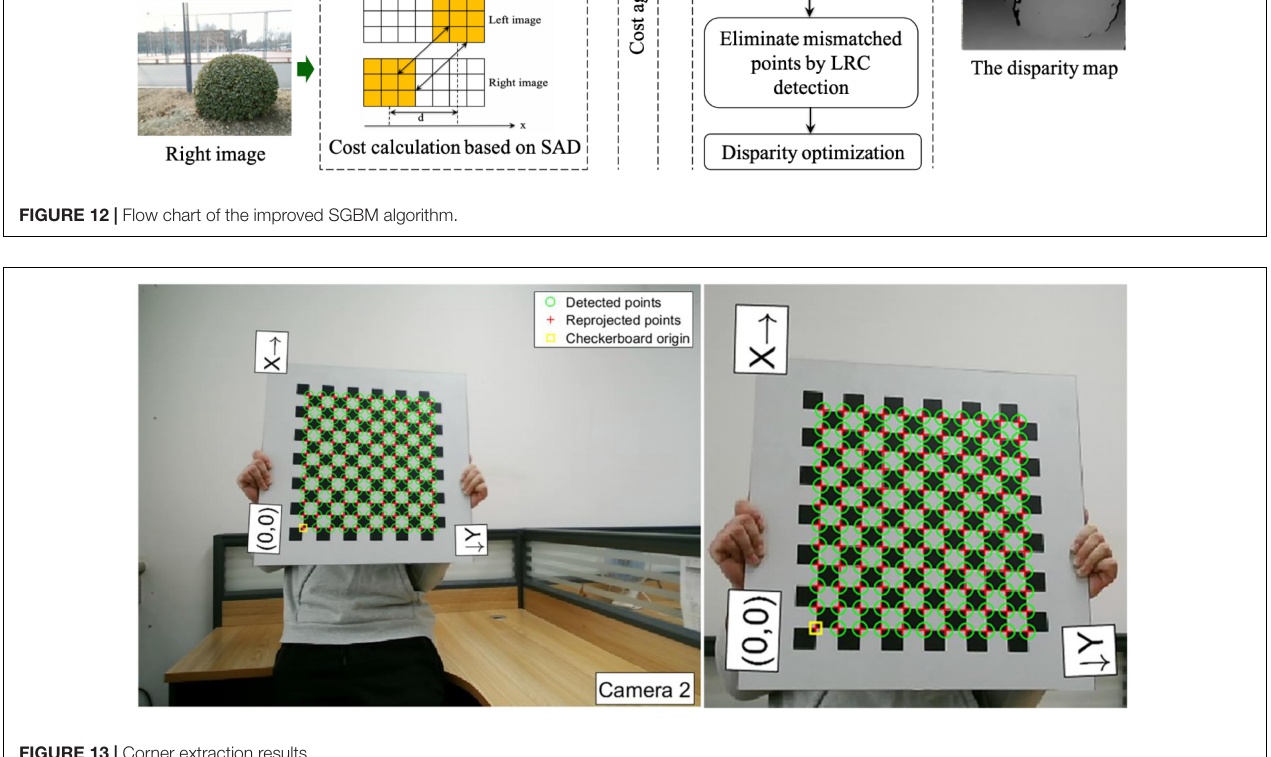
FIGURE 13 | Corner extraction